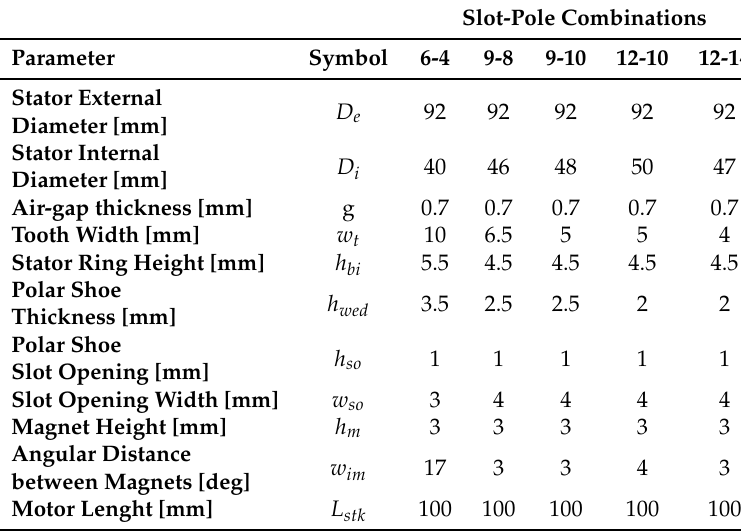
Table 5. Parameters of Healthy Slot-Pole